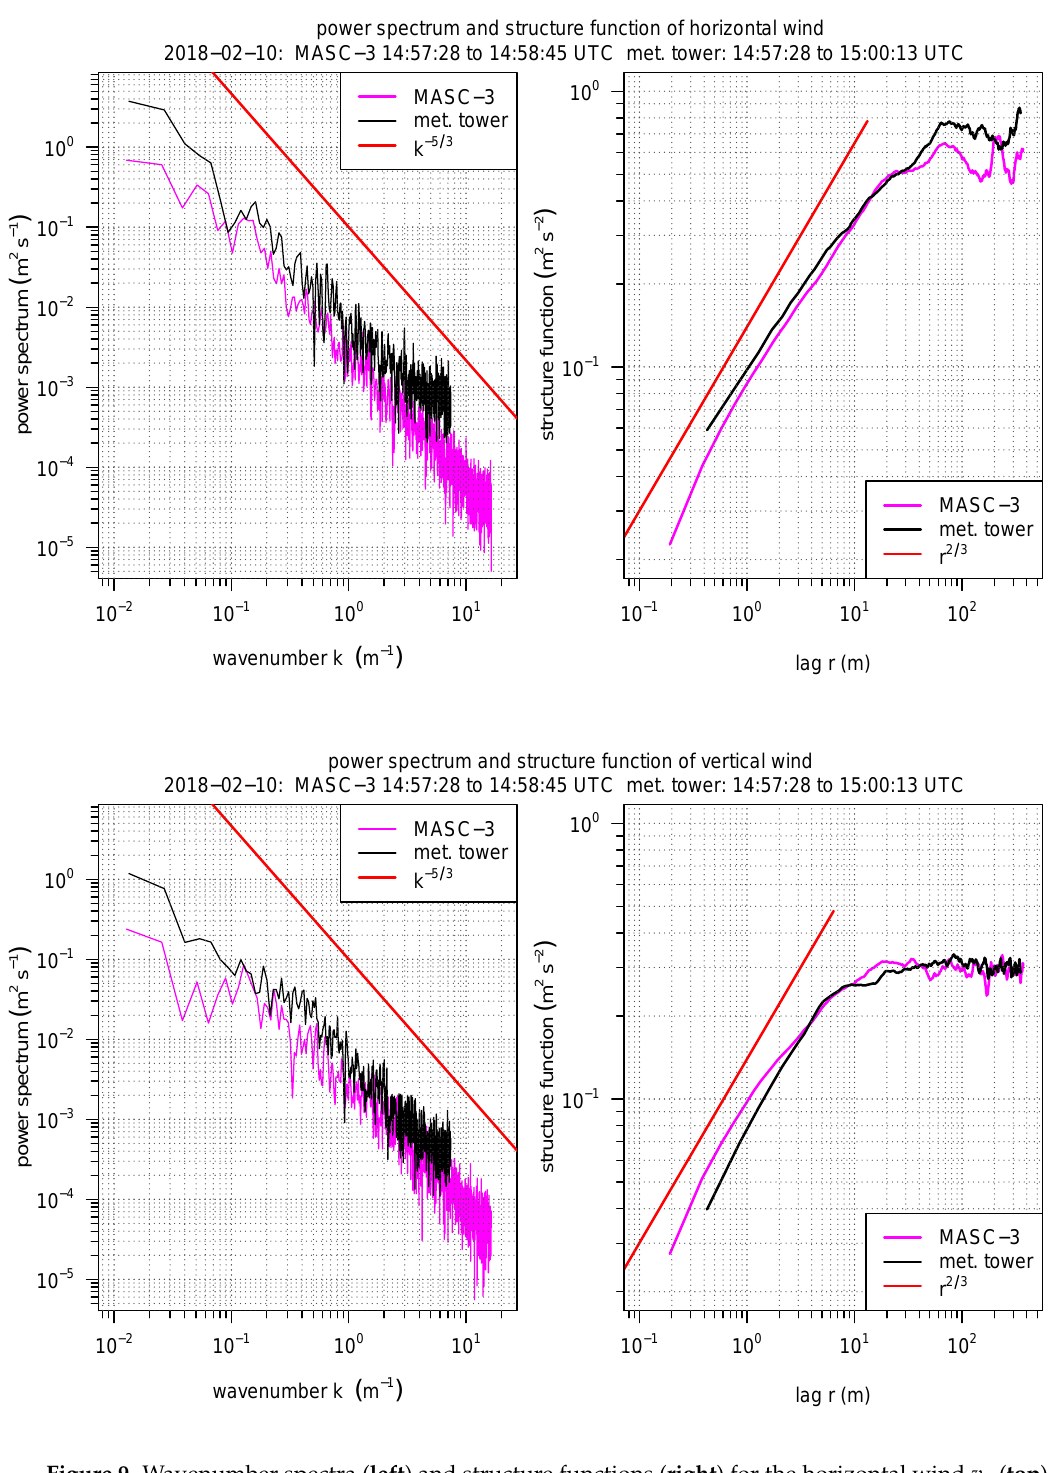
Figure 9. Wavenumber spectra ( left ) and structure functions ( right ) for the horizontal wind v h ( top ) and the vertical wind vector component w ( bottom ). The data of the tower at the 10.3 m level inherits a time series of ∆ t tower = 165 s, corresponding to the fetch of the MASC-3 flight leg with a duration of ∆ t = 77 s. Flight #10 and the first leg at 11.7 m AGL is UAS